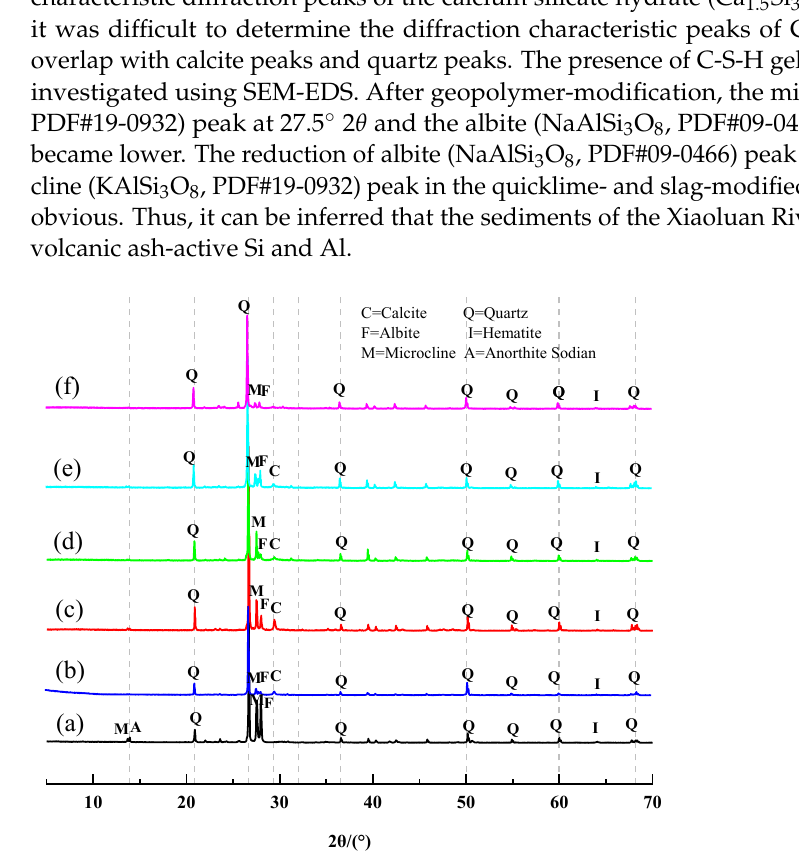
Figure 7. Change of compressive strength in 90 days curing age immersion curing.